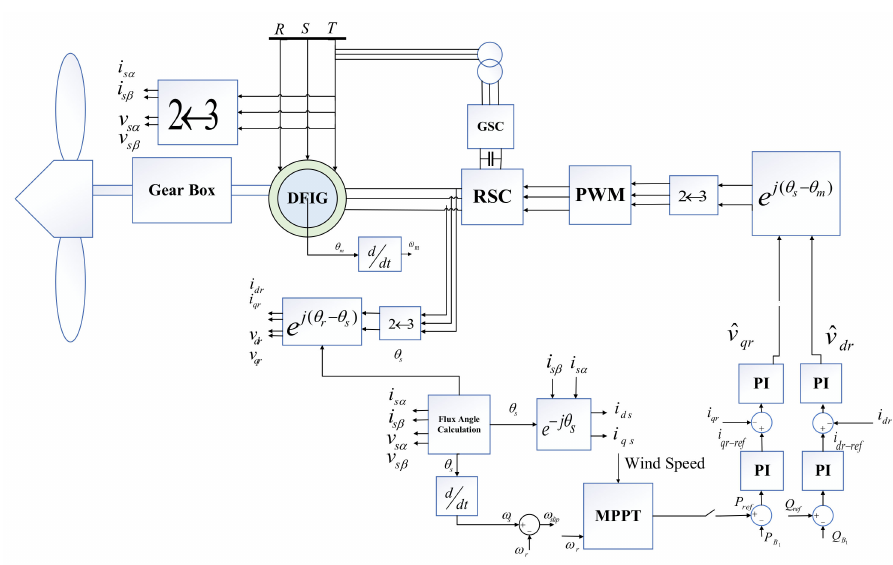
Figure 7. Overall control framework of doubly fed induction generator